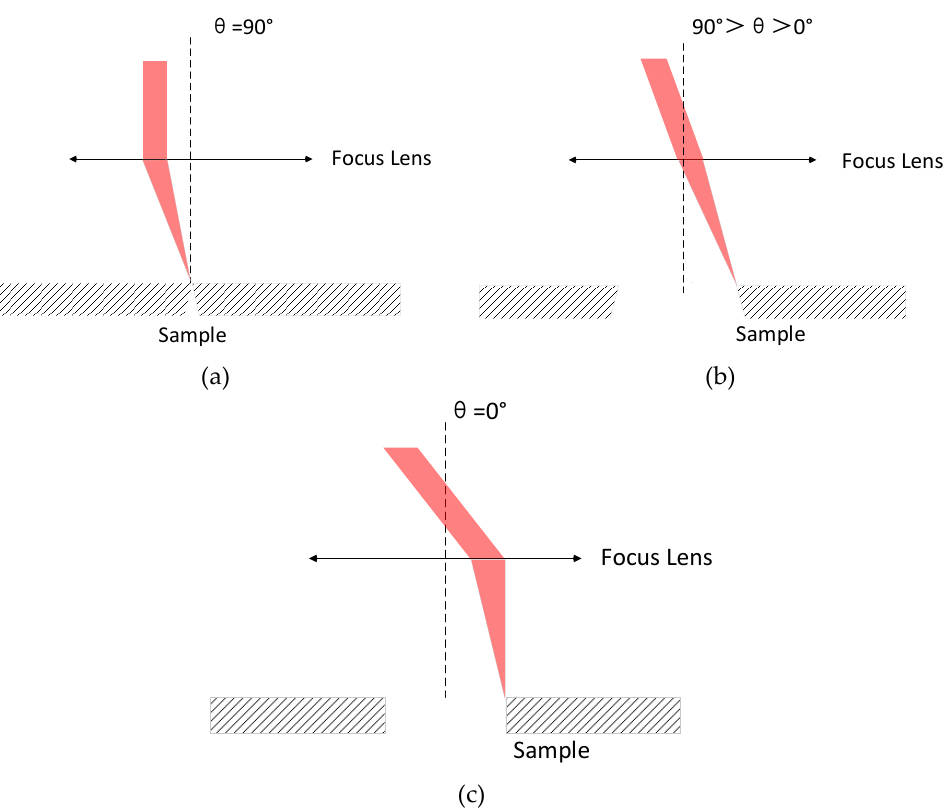
Figure 11. The relationship between the relative rotation angle of the double wedges of spiral drilling apparatus and the beam angle.